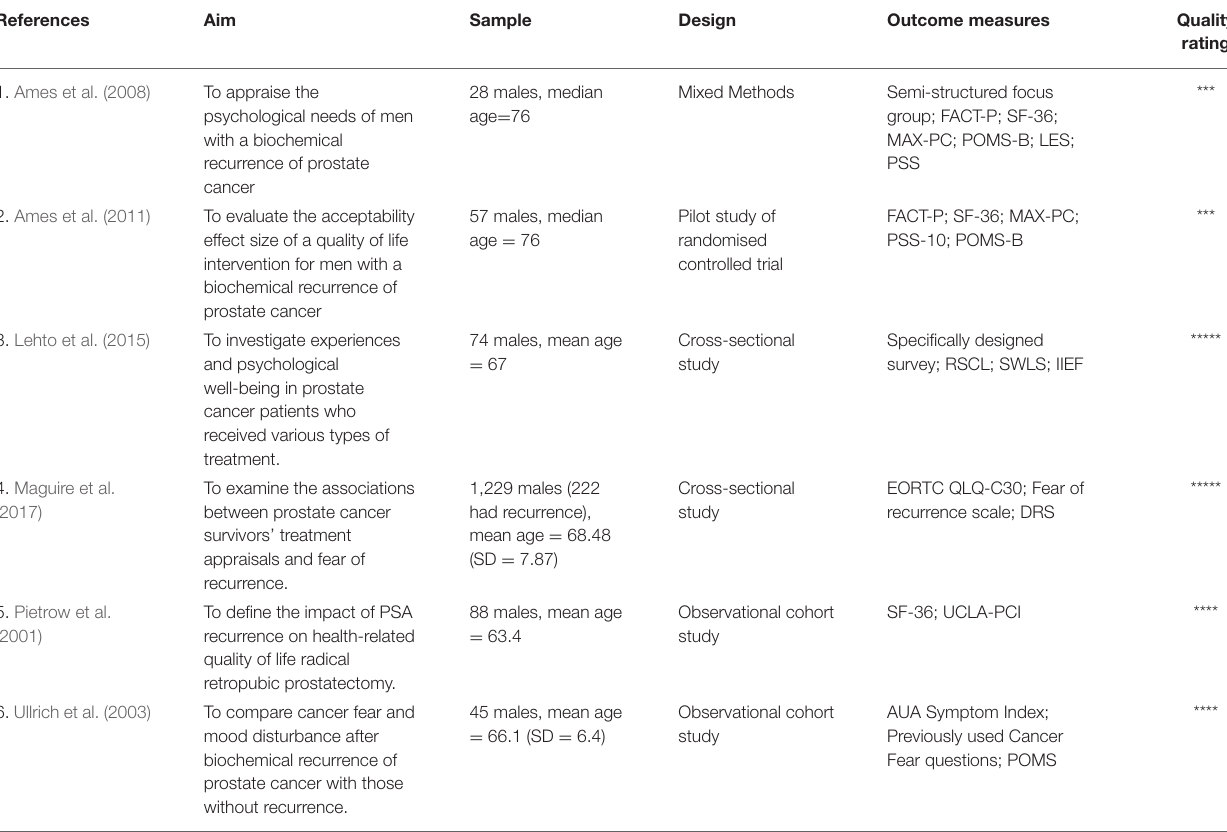
TABLE 2 | Prostate cancer studies included in